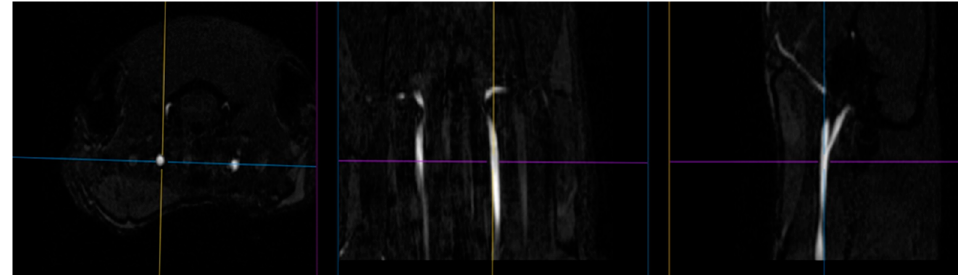
Figure 14. The images of the carotid arteries in three projections (in order to select the area of blood flow assessment).